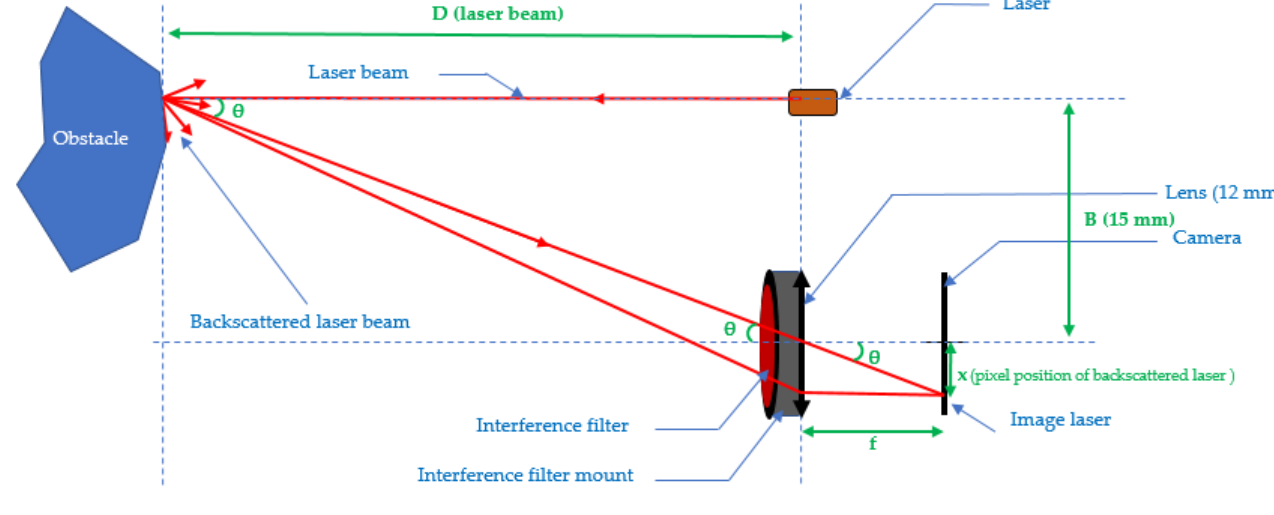
Figure 1. Presentation of basic scheme for one beam .